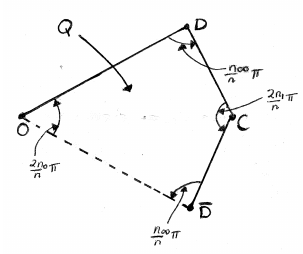
Figure 3. The image Q of the fundamental domain D under the mapping δ . The open edges OD , CD , and CD of the quadrilateral are included; while the open edge OD is excluded.